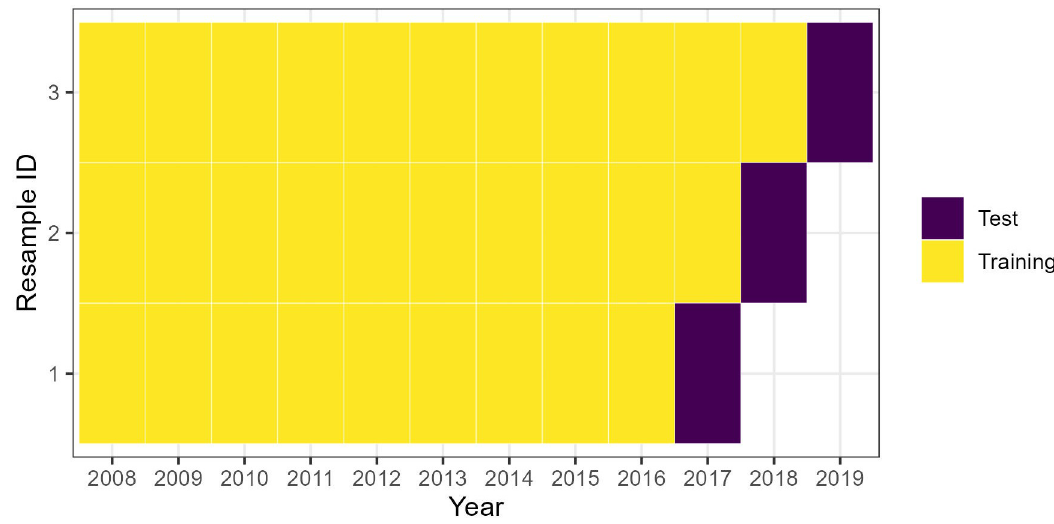
Fig 4. Data splits for